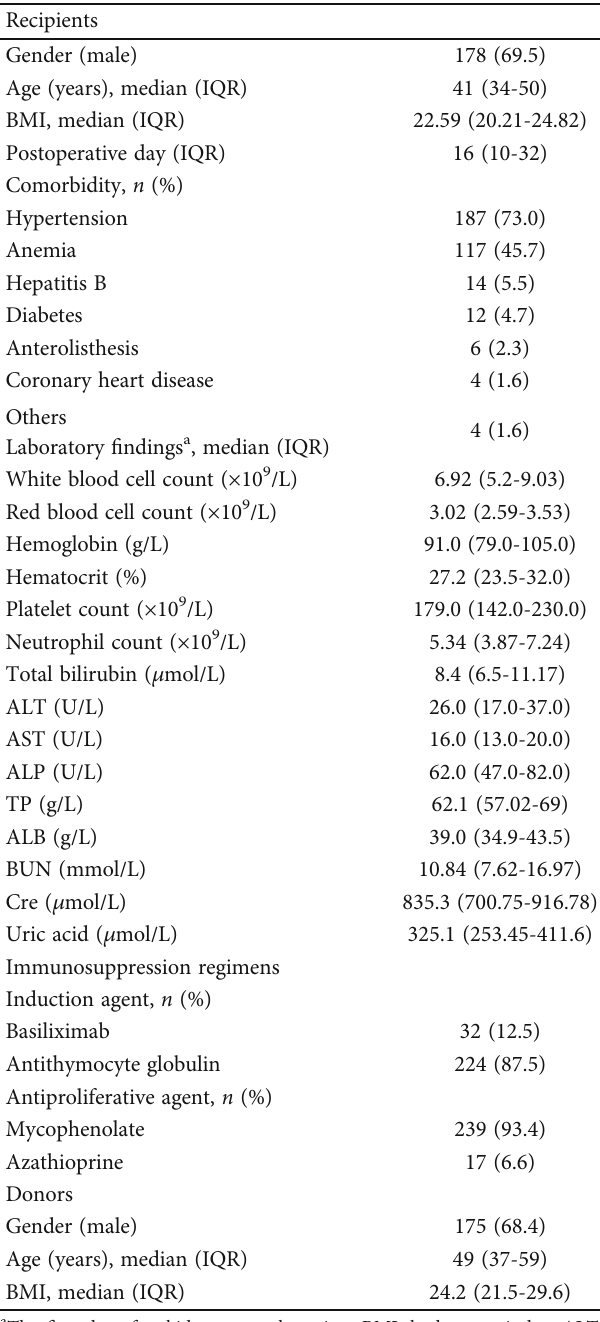
Table 1: Demographic characteristics of kidney transplant recipients and